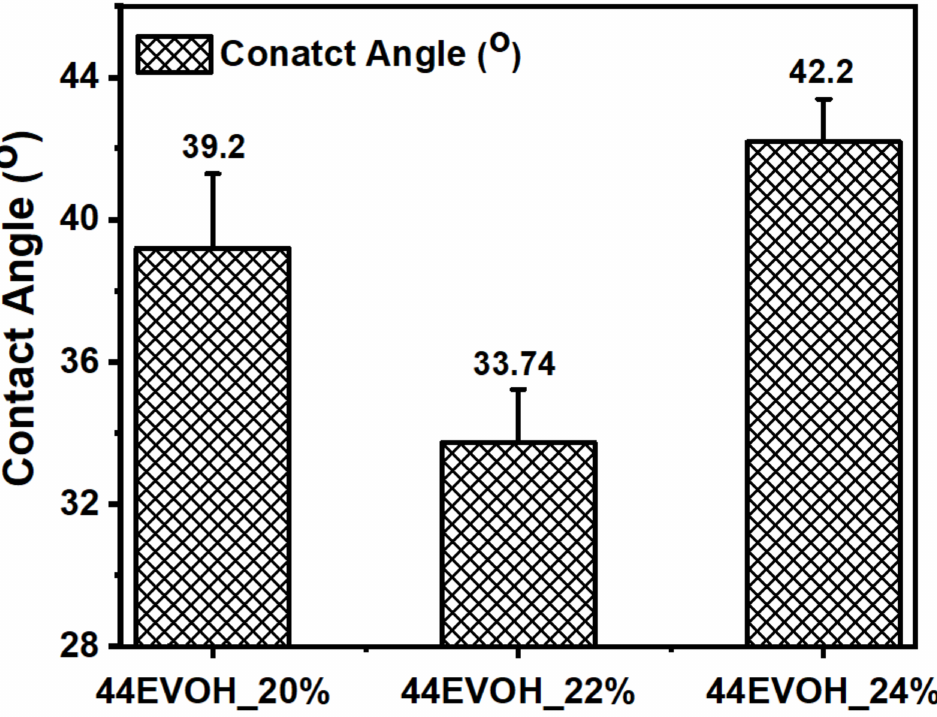
Figure 4. Water contact angle of the 44EVOH nanofibers corresponding to the respective polymer